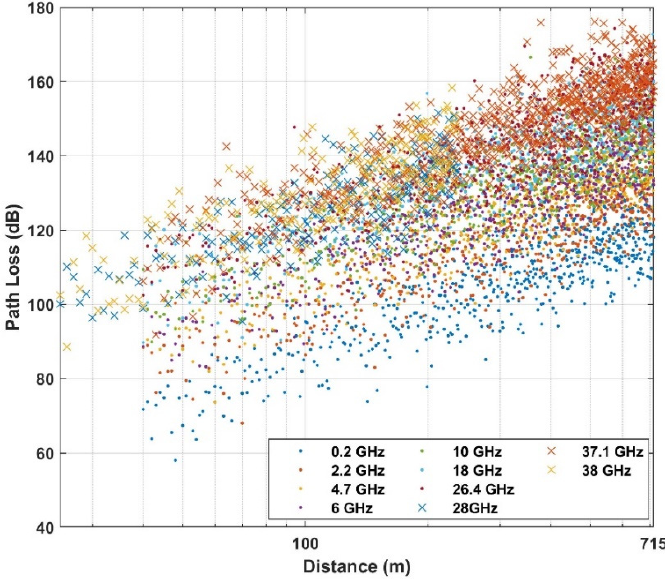
Figure 3. Empirical path loss at below rooftop in urban high-rise environment.